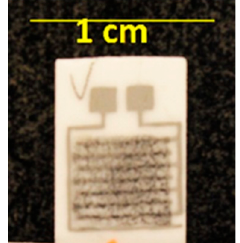
Figure 2. A picture of a CGB sensor screen printed sensor.